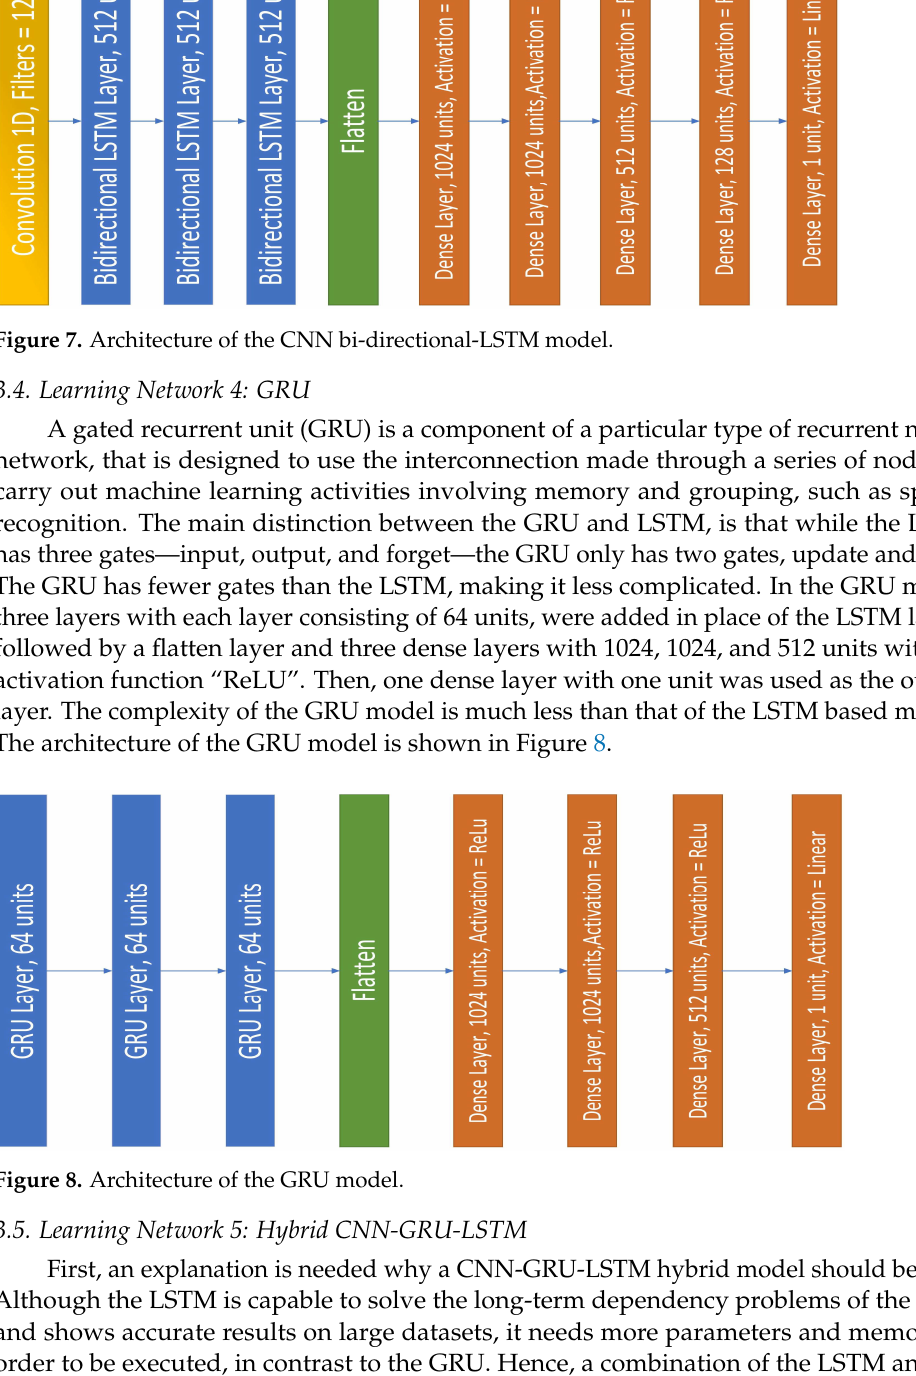
10 of 27 Figure 6. Architecture of the CNN-LSTM model. 3.3. Learning Network 3: CNN-Bi-Directional LSTM A bi-directional LSTM, also known as a Bi-LSTM, is a sequential computational framework, that consists of two LSTMs, one of which receives the input in forward time order, and the other receives the input in backward time order. The CNN-bi-directional LSTM architecture is almost the same as the CNN-LSTM model, except for the bi-direc-